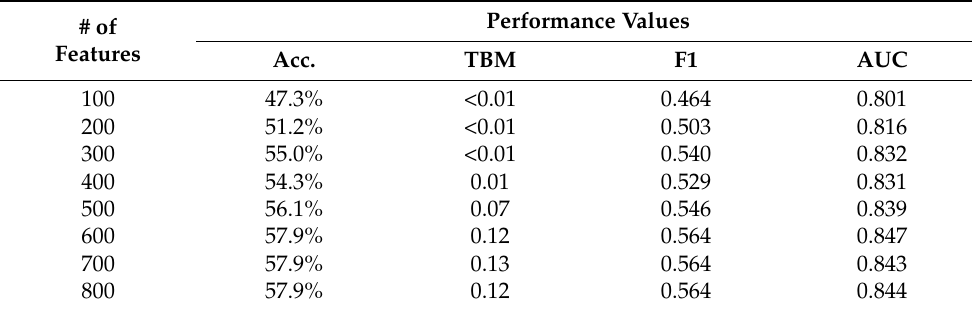
Table 7. The best performance of NB over different feature